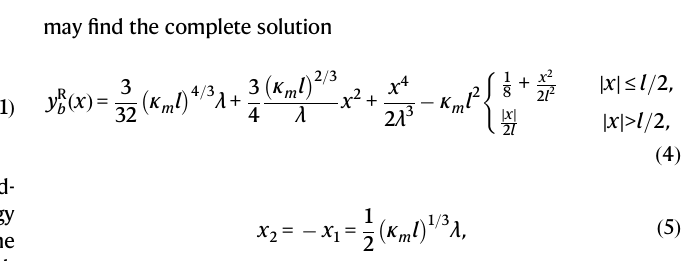
with l =2.7mmand κ R m = 0.8mm − 1 fortherectangularstimulusand κ G m = 1mm − 1 for the Gaussian, and (iii) a snap-shot from the experiment in which the beam has FWHMmatching l andpeakintensityof I m =3.55W/cm 2 .Allthe imagesinthepanel c are in scale with the scale bar of length 0.5mm. Throughout the fi gure the red marks the stimulated part of the strip, while the orange the